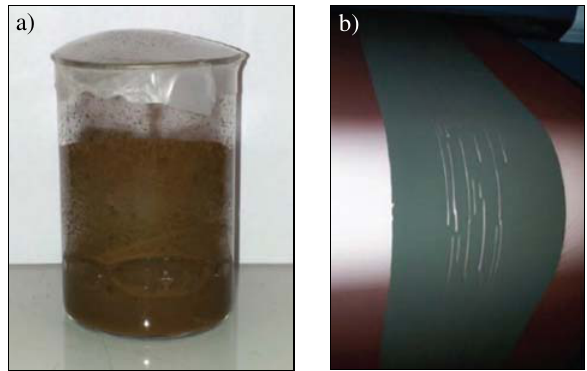
Figure 5. (a) Picture showing the gas (H mixing of a suspension containing Si nanoparticles to prepare an electrode. (b) Resulting Cu-supported casted electrode where bubbles in the slurry have induced a non-uniform coating. Reprin- ted from 26 with